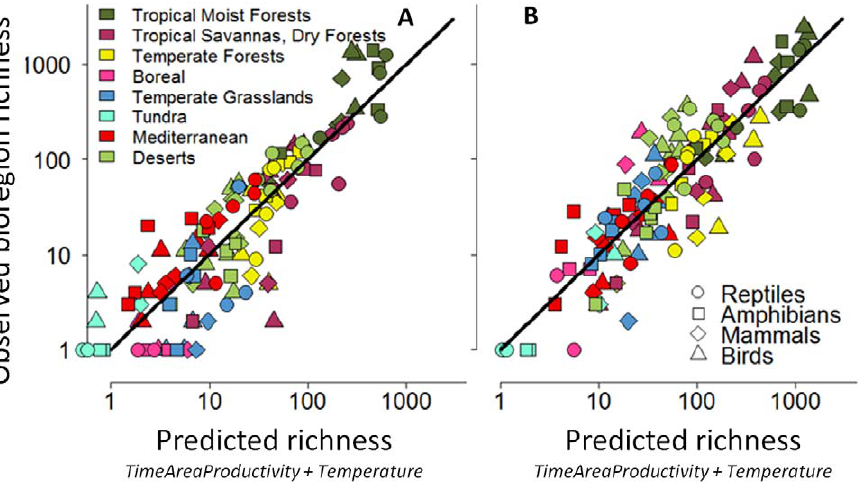
Figure 2. Observed versus predicted bioregion species richness of terrestrial vertebrates. Observed bioregion species richness (A, Endemic species, B, Resident species) is plotted against that predicted by the two-predictor TimeAreaProductivity + Temperature model fit separately for each of the four taxa (different symbols). Lines indicate least squares fit of regressions relating to observed predicted richness for each of the four taxa over the 32 bioregions ( r 2 [ Endemic ]=0.78, r 2 [ Resident ]=0.78, N =128). For detailed results, see Table S7. Colors indicate biome membership (see the map in Figure 1 to match colors).